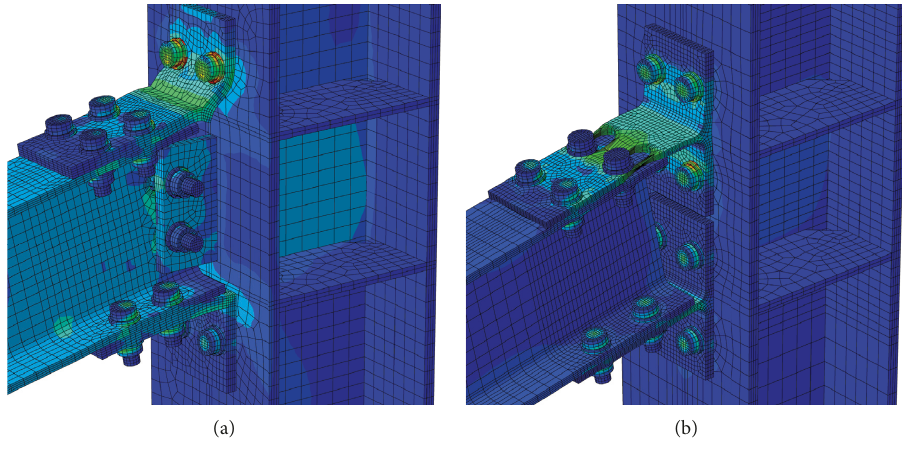
Figure 18: Local deformation. (a) J-1. (b) J-2. Table 5: Comparison of joint